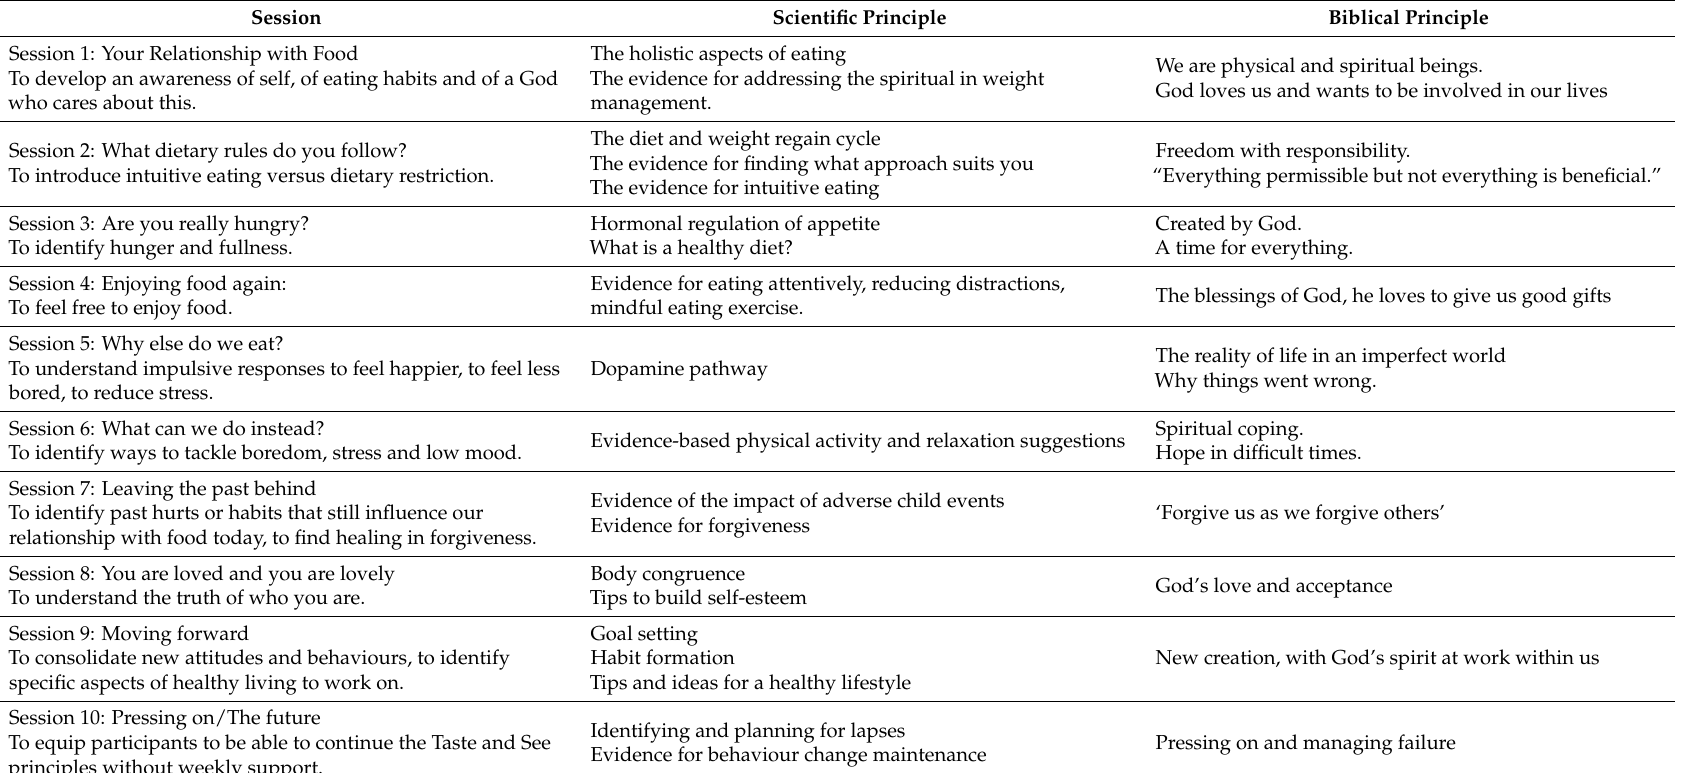
Table 1. Content of the Taste & See